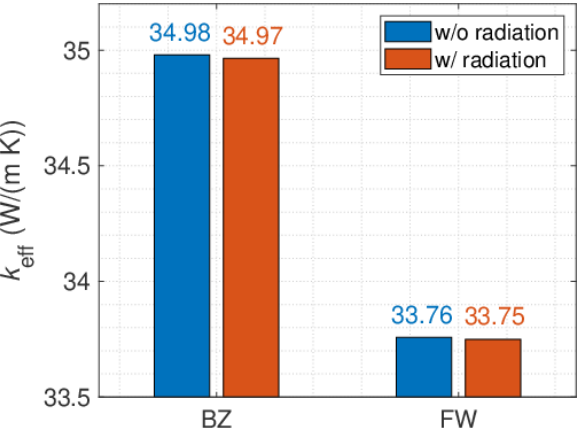
Figure 8. Effective thermal conductivities with and without radiative heat transfer on back surface.